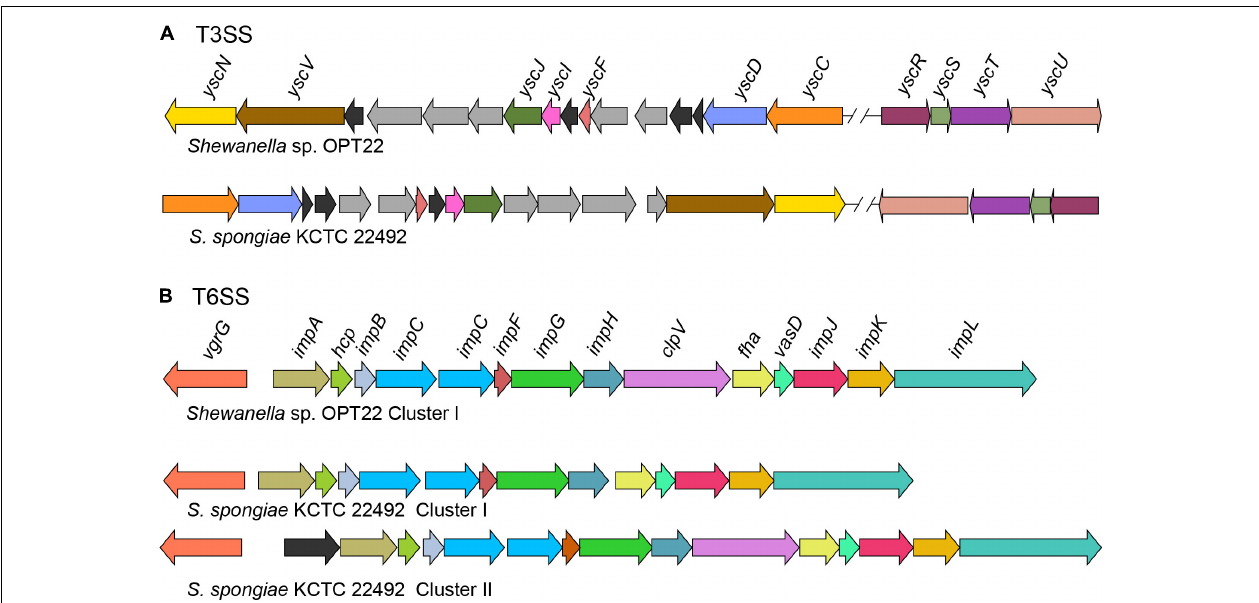
FIGURE 6 | Genetic organization of major SSs in Shewanella sp. OPT22 sequenced in this study and S. spongiae KCTC 22492. (A) Predicted type III secretion system (T3SS) core components in the genome of OPT22 and KCTC 22492. Detected T3SS clusters are shown as cluster I and cluster II. Gene clusters detected in different contigs are separated by double cross-hatched lines. (B) Predicted genes coding for type VI secretion system (T6SS). One gene cluster was detected in the OPT22, whereas two clusters (cluster I and cluster II) in KCTC 22492. Different color schemes are given for each predicted genes in all the SSs. Functionally related group of genes are indicated with the same color in each SS. Black (T3SSs and T6SSs) and dark-gray (T3SS) colors denote predicted hypothetical and unrelated genes. The genes are not shown to